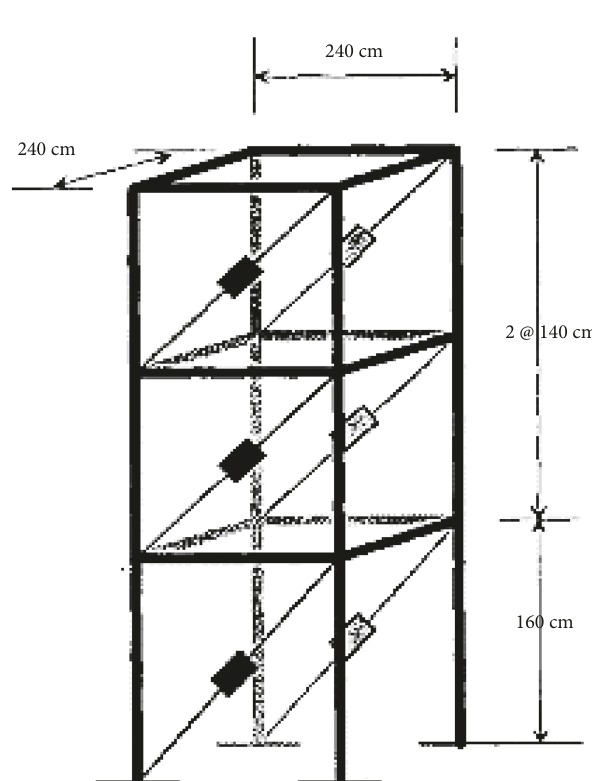
Figure 4: Dimensions and size of the building under test